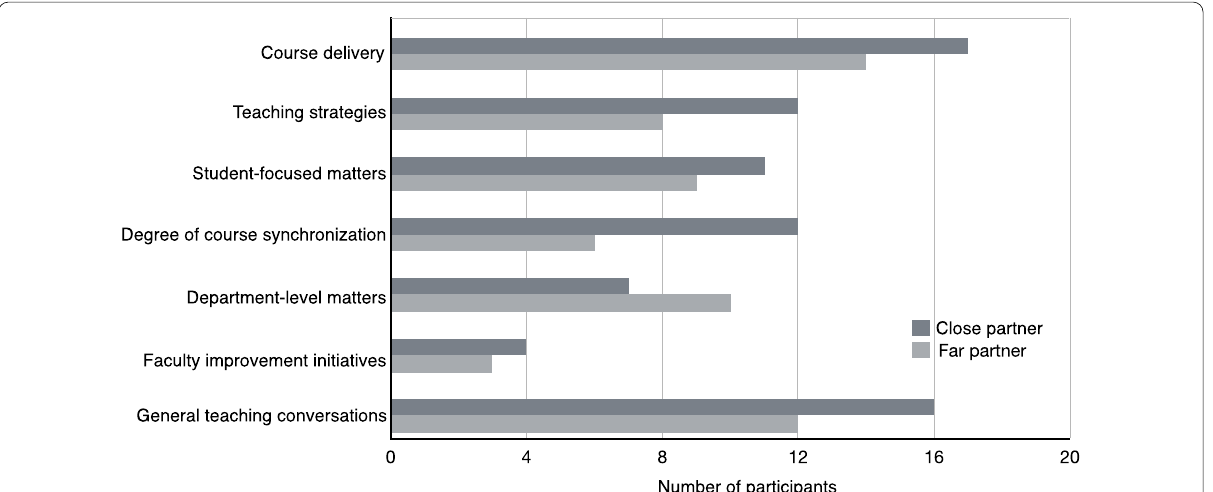
Fig. 4 Types of knowledge shared between faculty during teaching-related conversations. Bars represent the number of interview participants ( n 19) whose interactions with close (dark gray) and far (light gray) partners included discussion and information sharing related to the given = category. Discussion pairs could share more than one information type. Results broken down into additional subcategories are located in